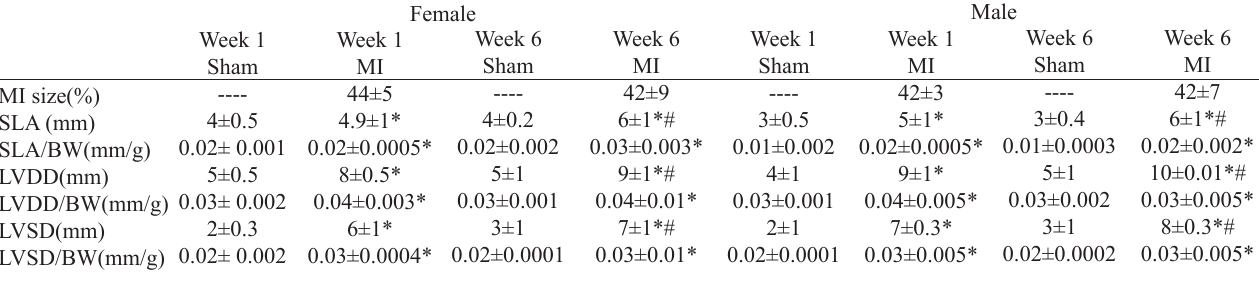
Table 1. Echocardiographic morphology parameters for female and male rats post-MI.